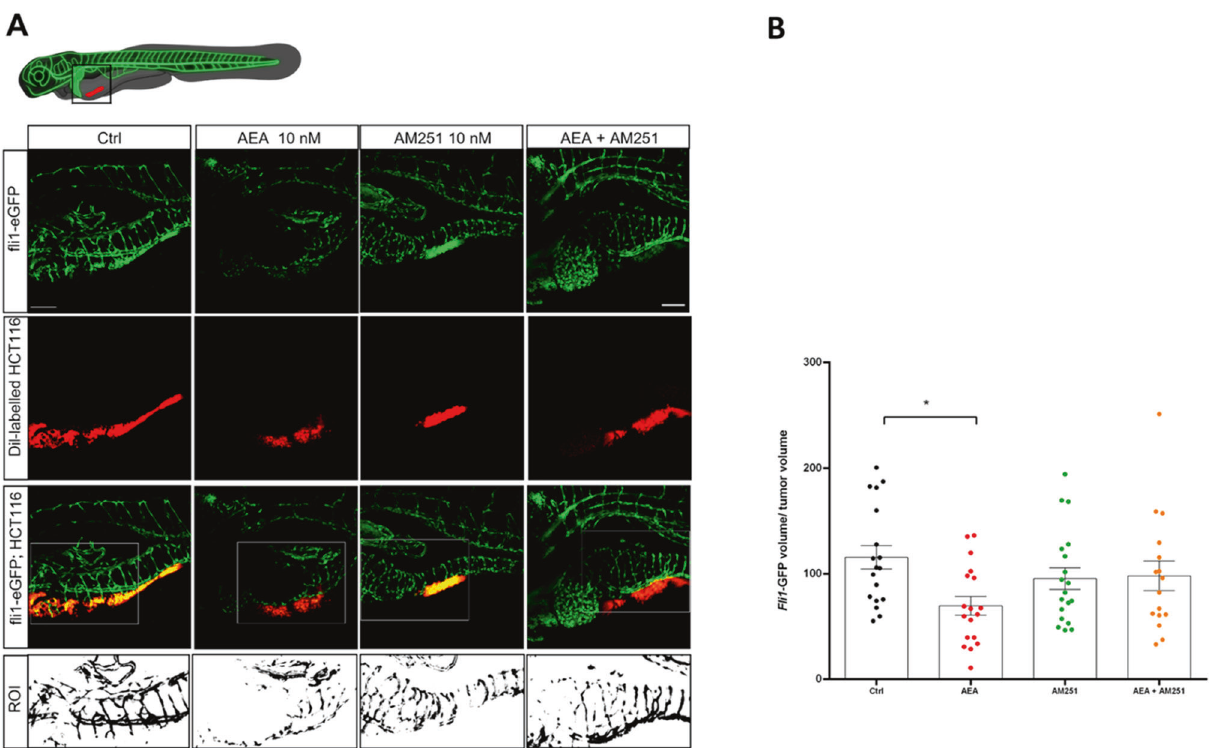
Fig. 2 AEA reduces vascularization in fl i1 -GFP positive xenografts. A Representative confocal z-stack images of 5 dpf (3 dpi) larvae with the tumor highlighted by the red fl uorescence (Dil Vibrant red staining) and blood vessels marked by the green fl uorescence (Tg( fl i1 :EGFP) y1 line). Scale bar 100 µm. The white box indicates the region of interest (ROI) selected to quantify the vascularization. B Quanti fi cation of total green fl uorescence of the ROI analyzed with Fiji. The mean value in the Ctrl was settled as 100%. The error bar indicates SEM. Statistical analysis was performed using one-way ANOVA. * p < 0.05; (Ctrl n = 18; AEA n = 18; AM251 n = 19; AEA + AM251 n = 16 from three independent experiments). Image created with